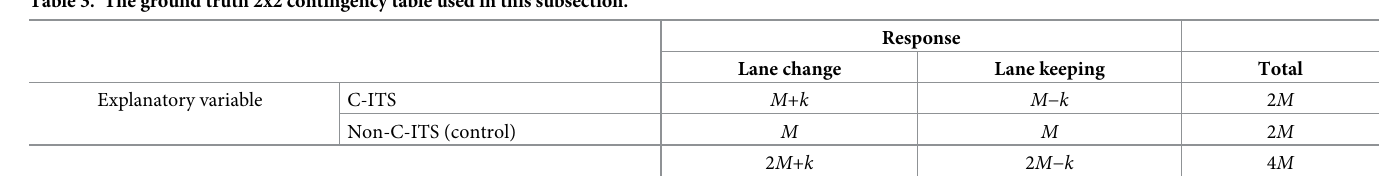
Table 3. The ground truth 2x2 contingency table used in this